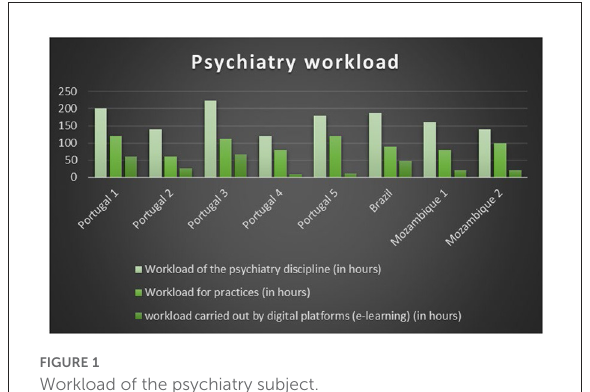
FIGURE1 Workload of the psychiatry subject.